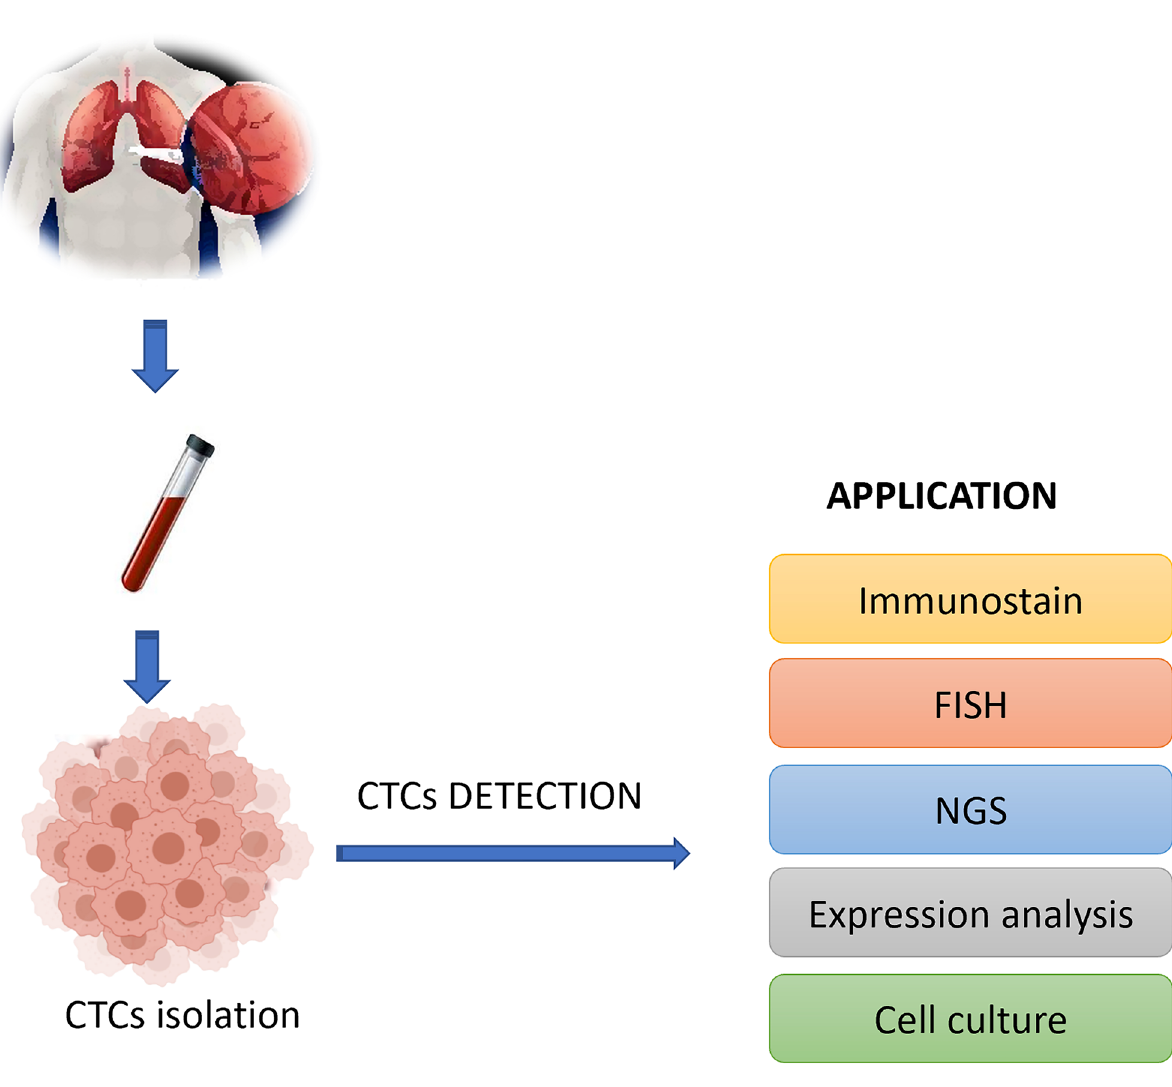
Figure 2. Applications of CTC